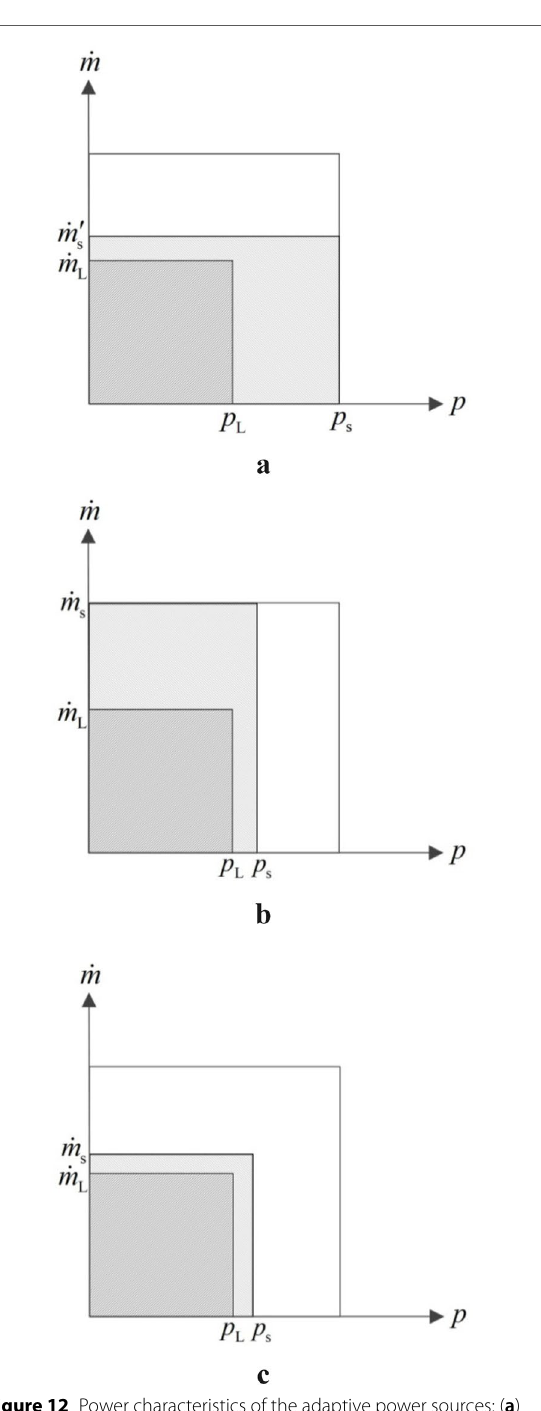
Figure 12 Power characteristics of the adaptive power sources: ( a ) Flow adaptive power source, ( b ) Pressure adaptive power source, ( c ) Power adaptive power